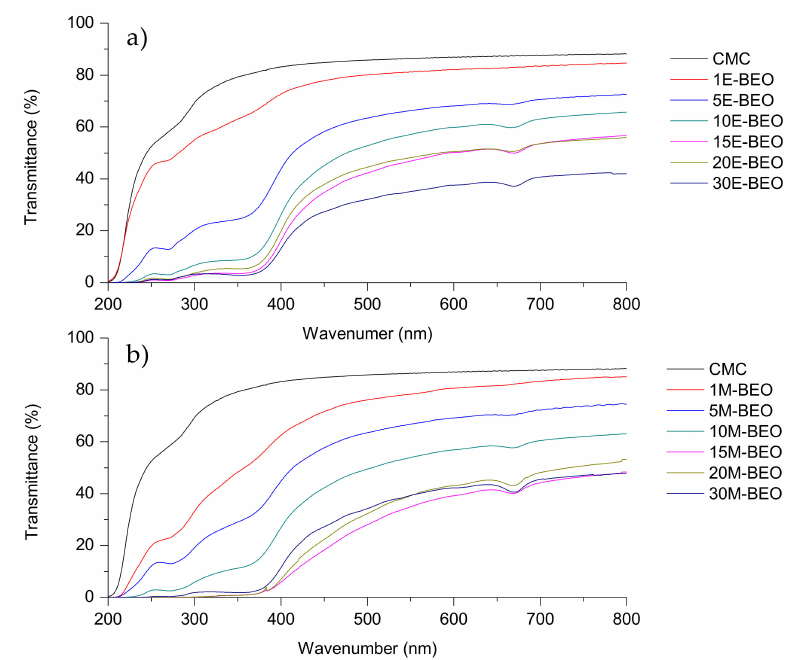
Figure 4. UV-VIS Spectra profile of CMC films formulated with di ff erent concentrations of BEO extracted with ( a ) ethanol and ( b ) methanol.